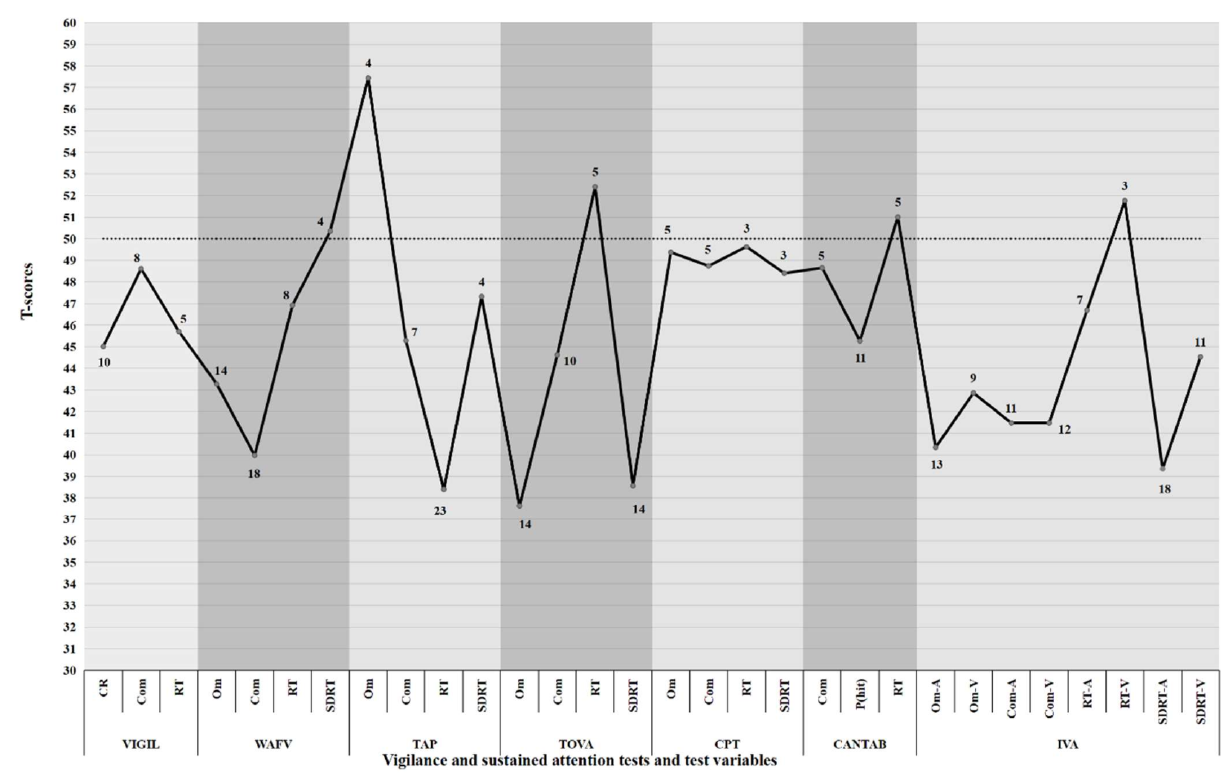
Figure 1. Graphical depiction of vigilance and sustained attention test performance ( T -scores) and number of patients with ADHD showing impairment ( T ≤ 40) in each of the test variables. Note: All raw scores were converted to T -scores based on test norms. Test performance scores were converted, if applicable, such that lower T -scores indicate worse performance for all test variables. Data labels indi- cate the number of patients impaired in each test variable ( T ≤ 40). VIGIL = VIGIL of the Vienna Test System (VTS). WAFV = Perception and Attention Functions—Vigilance of the VTS. TAP = Test Battery for Attention Performance. TOVA = Test Of Variables of Attention. CPT = Conners’ Continuous Per- formance Test. CANTAB = Cambridge Neuropsychological Test Automated Battery—Rapid Visual Processing. IVA-2 = Integrated Visual and Auditory Continuous Performance Test. CR = Correct responses. Com = Commissions. RT = Reaction time. Om = Omissions. SDRT = Standard deviation of reaction times. P(hit) = Probability of a hit. Omi-A = Omissions, Auditory. Omi-V = Omissions, Visual. Com-A = Commissions, Auditory. Com-V = Commissions-Visual. RT-A = Reaction time, Auditory. RT-V = Reaction time, Visual. SDRT-A = Standard deviation of reaction times, Auditory. SDRT-V = Standard deviation of reaction times,